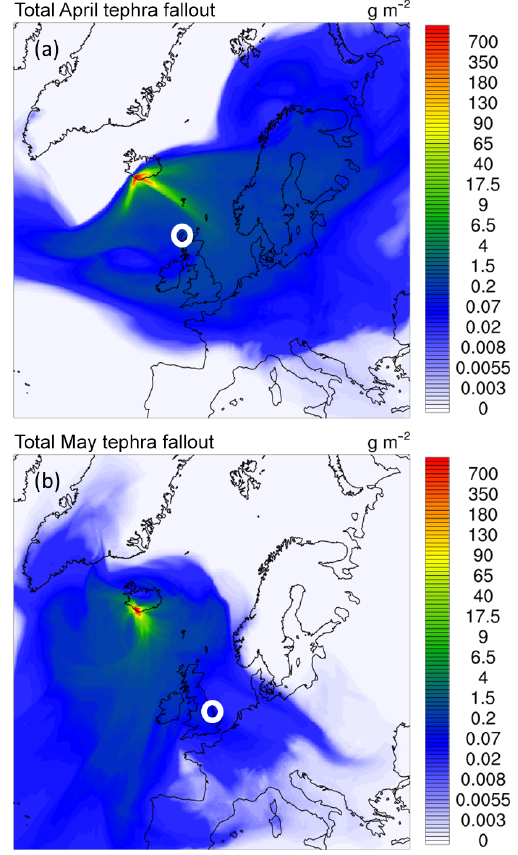
Figure 9. Mass of tephra fallout deposited on model surface and lowest model level in WRF-Chem, for April (a) and May (b) 2010 model simulations. The white circle in (a) marks the Outer He- brides, and the white circle in (b) marks Lincolnshire and Leicester- shire, UK, corresponding to sample areas in Stevenson et al. (2012). Maximum domain fallout is 52Mgm − 2